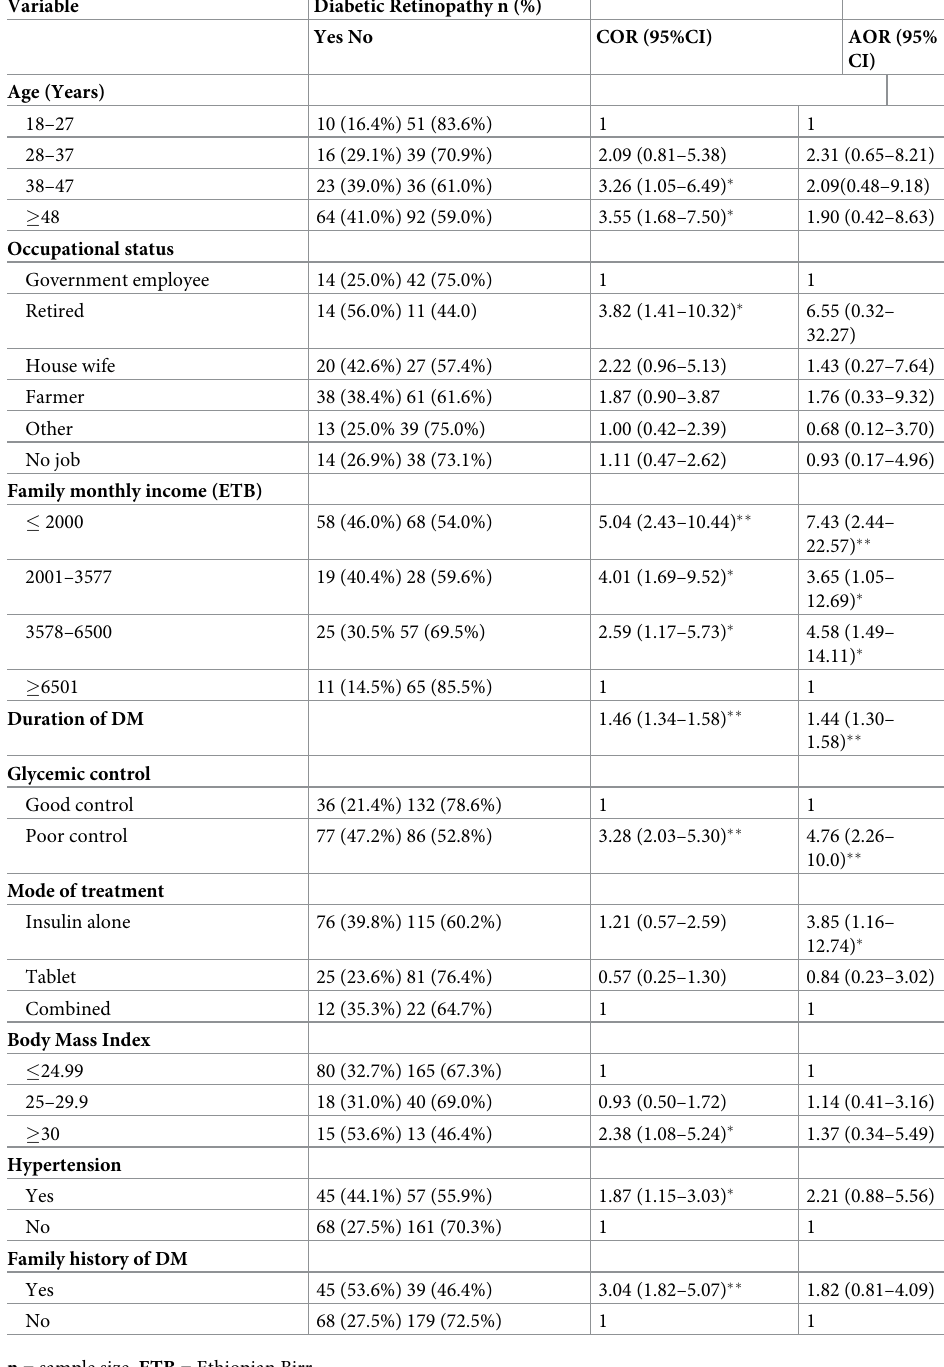
Table 4. Factors associated with diabetic retinopathy in diabetes patients at Debre Tabor General Hospital, Northwest Ethiopia 2020 (n =